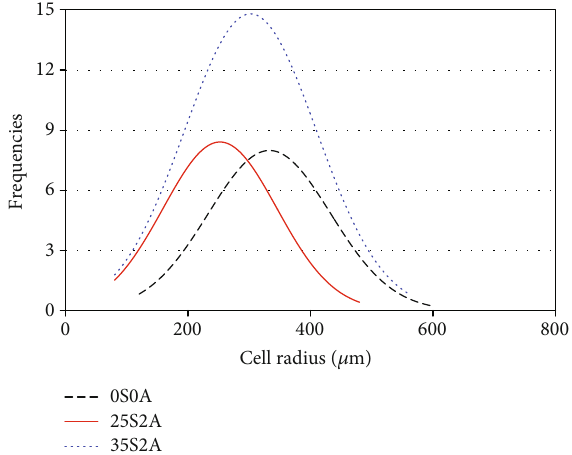
Figure 6: The e ff ect of surfactants on the properties of rigid PU foam.